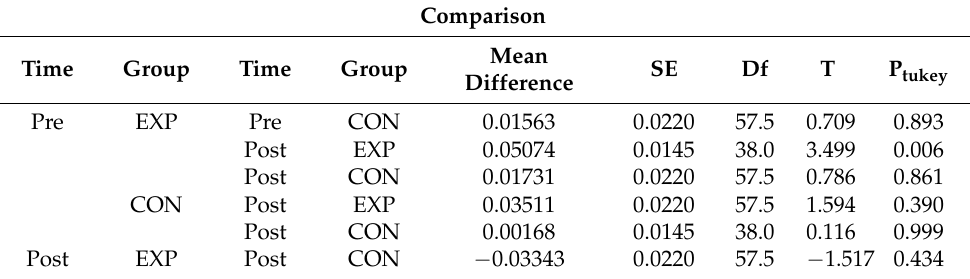
Table 4. Analysis of the Tc parameter post hoc comparisons-Time * Group.